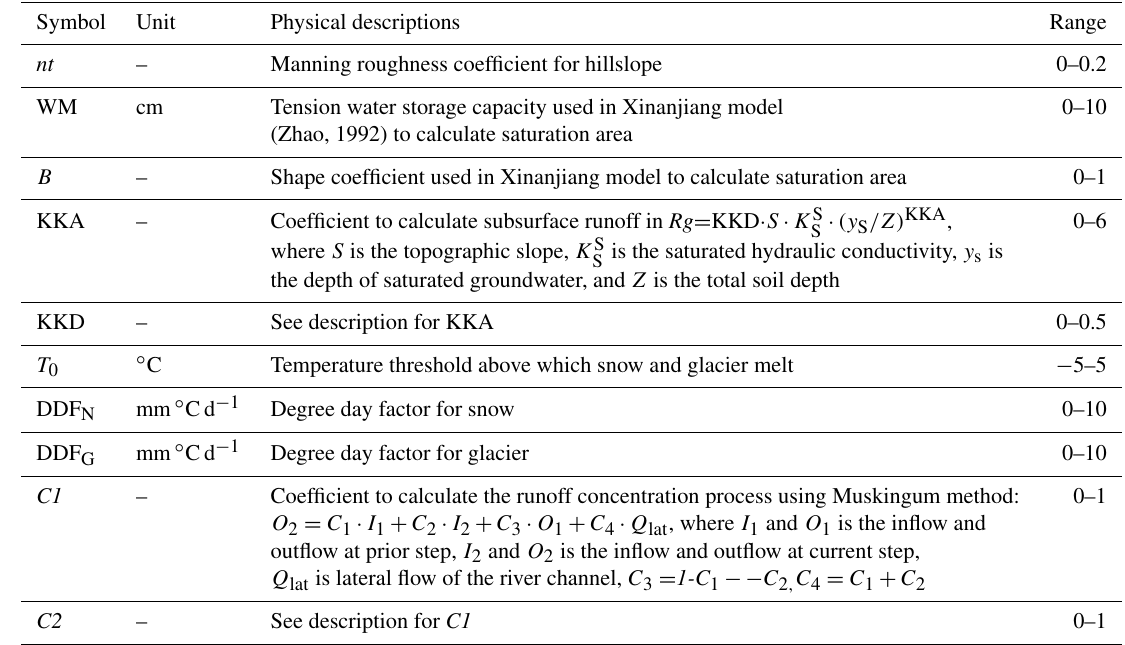
Table 2. Calibrated parameters of the THREW-t model.